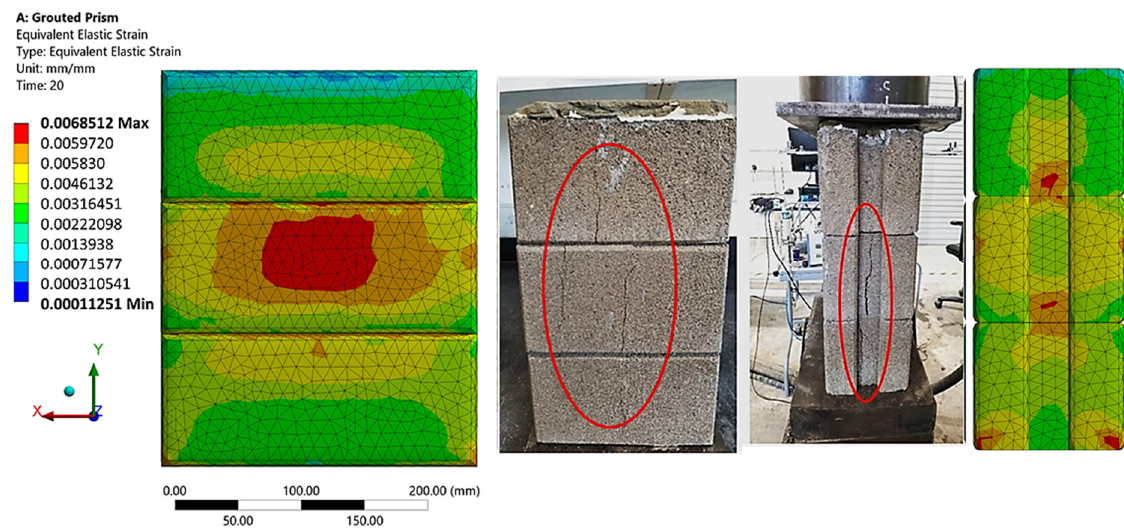
Figure 11. Failure mode (equivalent elastic strain) of grouted prism experimentally and FE model.